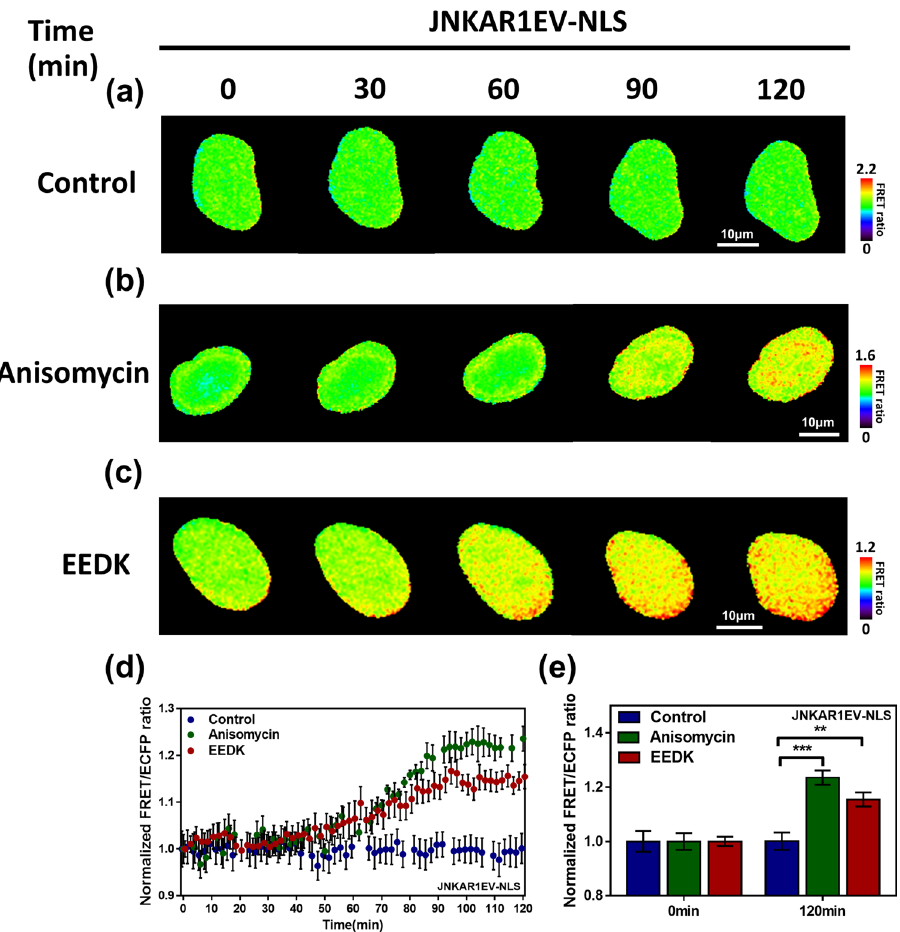
Figure 5. The effects of EEDK on the degree of JNK activation. ( a – c ) Time-lapse FRET images of JNKAR1EV- NLS in HEK293A cells exposed to the control (0.5% (v/v) DMSO), anisomycin (4 μM), and EEDK (50 μg/mL). Anisomycin was used as a positive control. The color scale bars represent the range of FRET/ECFP emission ratios of the biosensors. Hot and cold colors indicate high and low JNK activity, respectively. Scale bar = 10 μm. ( d ) The time courses represent the average of normalized FRET/ECFP emission ratio changes of JNKAR1EV- NLS. The dots are the mean values of normalized emission ratios, with error bars indicating the S.E.M (n = 6). ( e ) The bar graph describes the mean values of normalized FRET/ECFP emission ratios of the biosensor at 0 min and 120 min. The bar graph also contains error bars indicating the S.E.M (n = 6, ** P < 0.01, *** P < 0.001, Student’s t